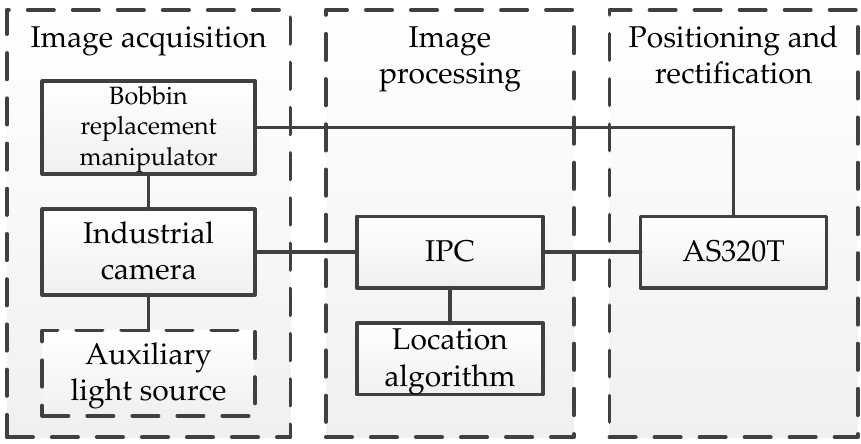
Figure 3. This is the composition block diagram of creel positioning system.